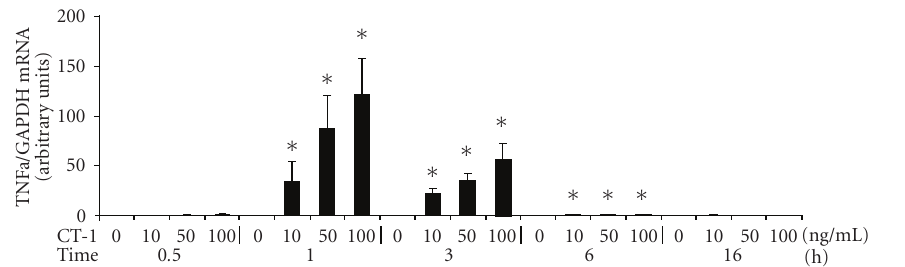
Figure 2: Concentration- and time-dependent induction of TNF α mRNA after incubation with CT-1. Human PBMCs were incubated with various CT-1 concentrations and for various periodes. After the indicated time mRNA was determined by real-time PCR. All TNF α mRNA expression data were normalized to GAPDH. n = 8, data are expressed as mean ± SEM. ∗ P < . 05 compared to unstimulated cells.